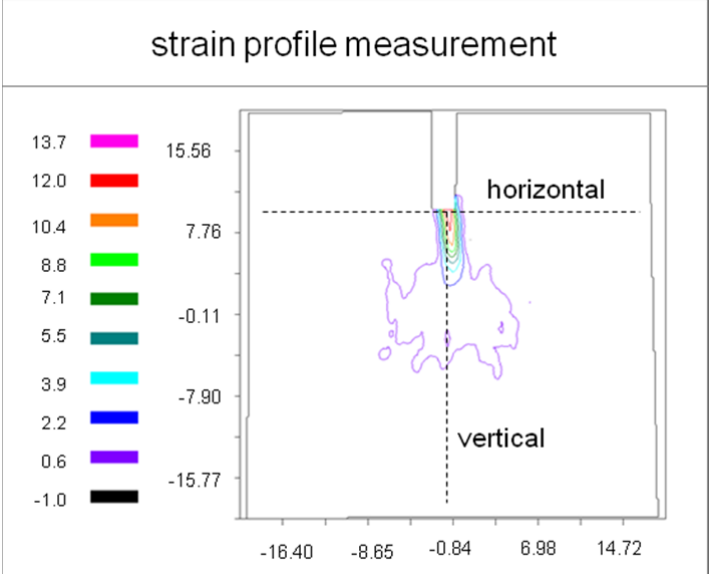
Figure 4. Contour graph of ε (µm/mm) showing the intersection lines were the horizontal xx and vertical profiles were